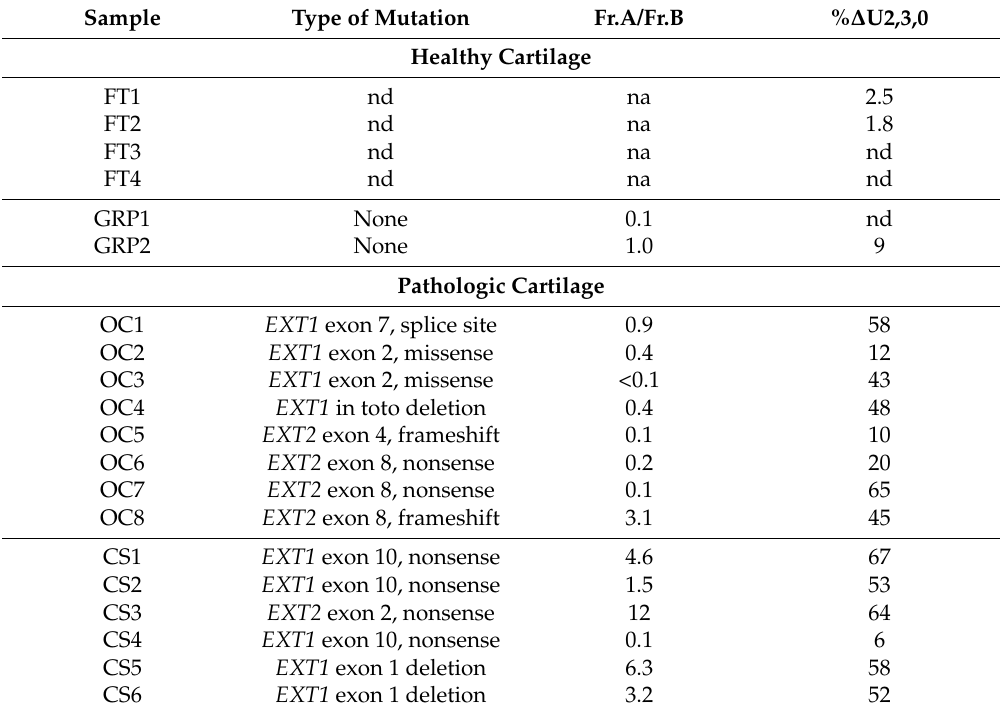
Table 2. Summary table of the quantitative evaluation of HPLC–MS profiles of all the analyzed samples. Fr.A/Fr.B represents the ratio between the total area of peaks of the corresponding fractions A and B. % ∆ U2,3,0 expresses the percentage value of the trisulfated disaccharide peak area with respect to the total peak area, specifically the percentage mean value of A and B fractions. The type of mutation is reported again as in Table 1. Sample Type of Mutation Fr.A/Fr.B % ∆ U2,3,0 Healthy Cartilage FT1 nd